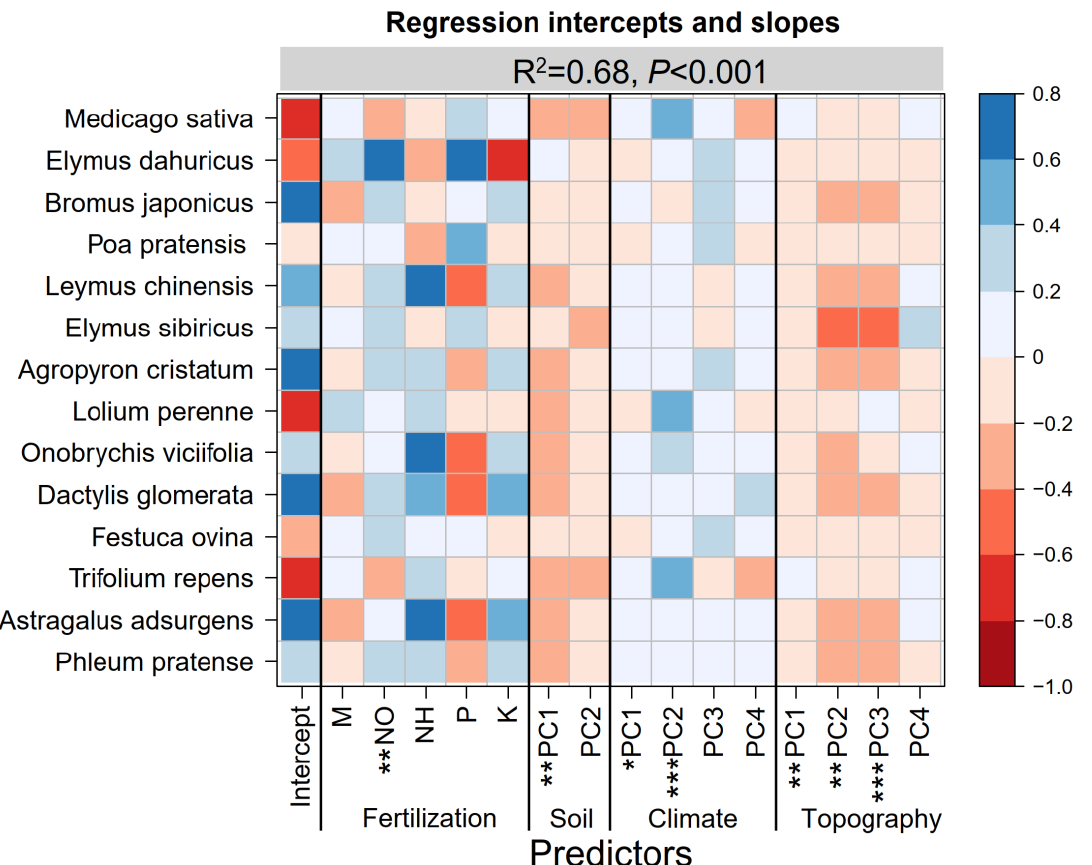
Figure 5. Coefficients of the fitted linear mixed-effects regression (LMER) in simulating AGB. Intercept is the intercept of the LMER. M, NO, NH, P, and K are the amounts of different fertilizers (manure, nitrate nitrogen, ammonium nitrogen, phosphorus, and potassium, respectively) applied during a plant growing season. PC1, PC2, PC3, and PC4 are the most important principal components (PCs) of different groups of driving factors (i.e., soil, climate, and topography). The R 2 for the LMER model is 0.68. *, ** and *** under the predicting variables indicate that the coefficients are statistically significant at the levels of p < 0.05, p < 0.01 and p < 0.001, respectively. Detailed principal component analyses on the predictor variables are presented in Figure A4.